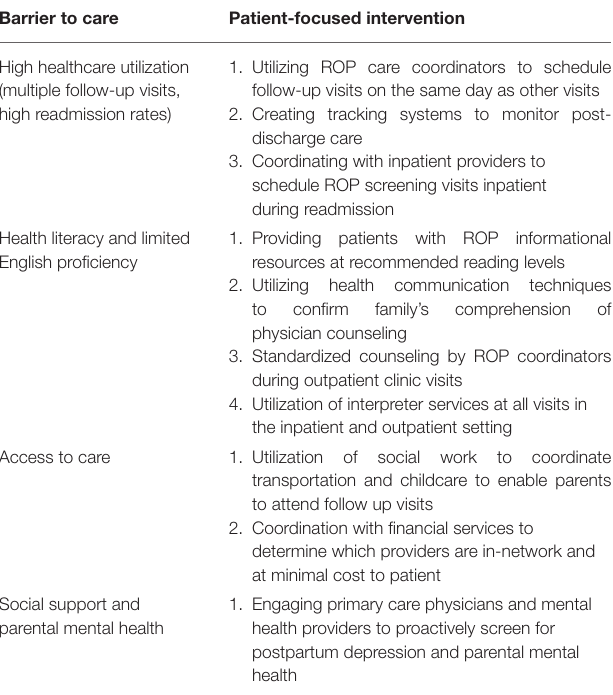
TABLE 2 | Patient-oriented solutions to improve outpatient ROP follow